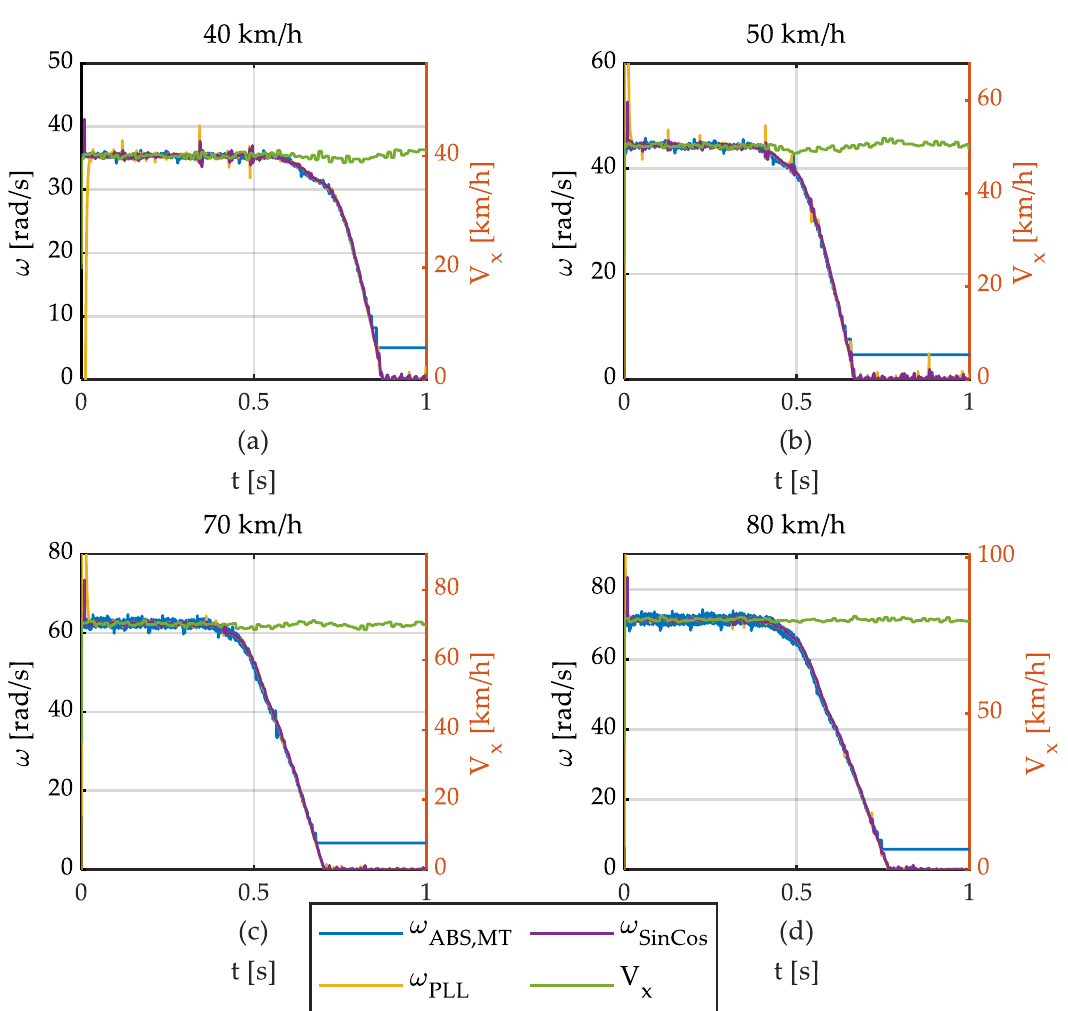
Figure 17. Wheel speed and linear speed vs. time. Different vehicle speeds. ( a ) 40 km/h. ( b ) 50 km/h. ( c ) 70 km/h. ( d ) 80 km/h.